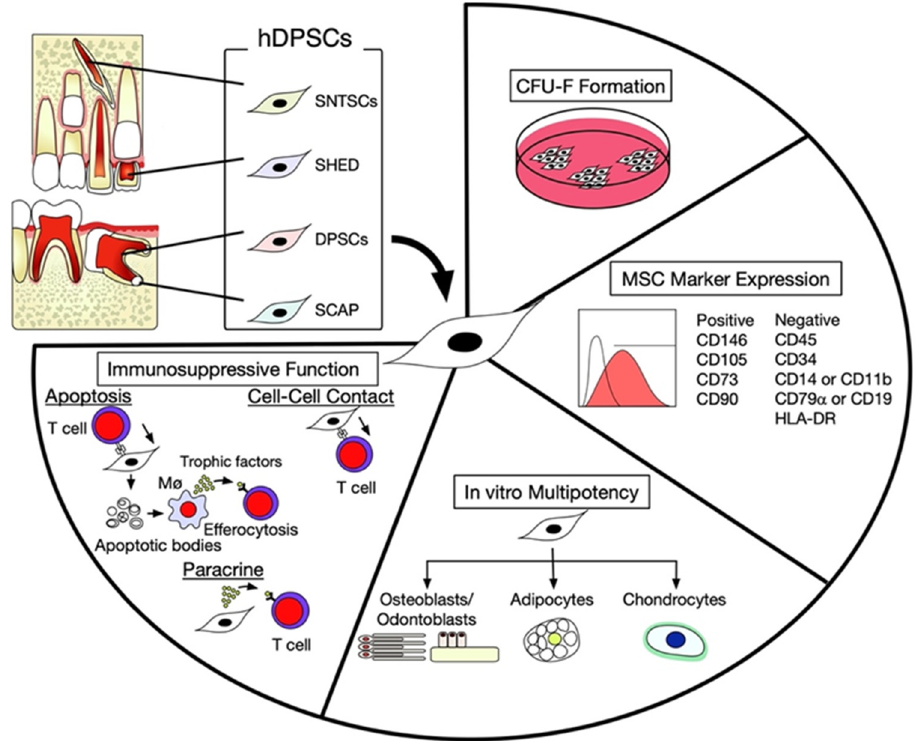
Figure 1. Class and characterization of human dental pulp-derived stem cells (hDPSCs). hDPSCs can be isolated from dental pulp tissues of deciduous, permanent, supernumerary teeth, and apical papillae of immature tooth roots, such as impacted wisdom teeth. hDPSCs exhibit mesenchymal